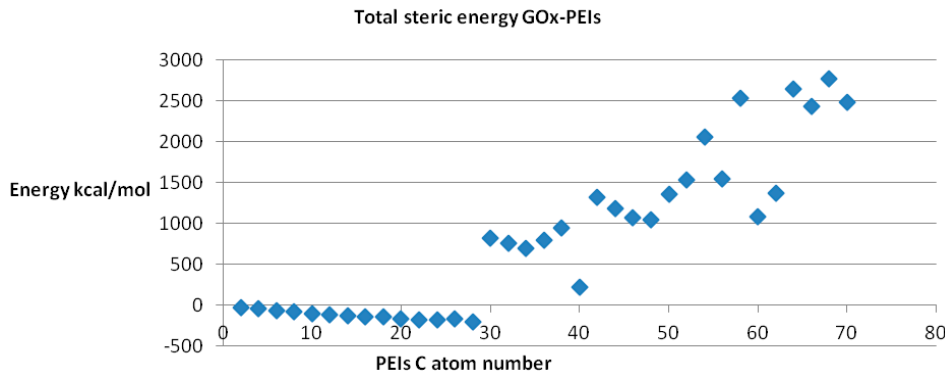
Figure 9. Steric energy values of GOx-LPEI complexes.